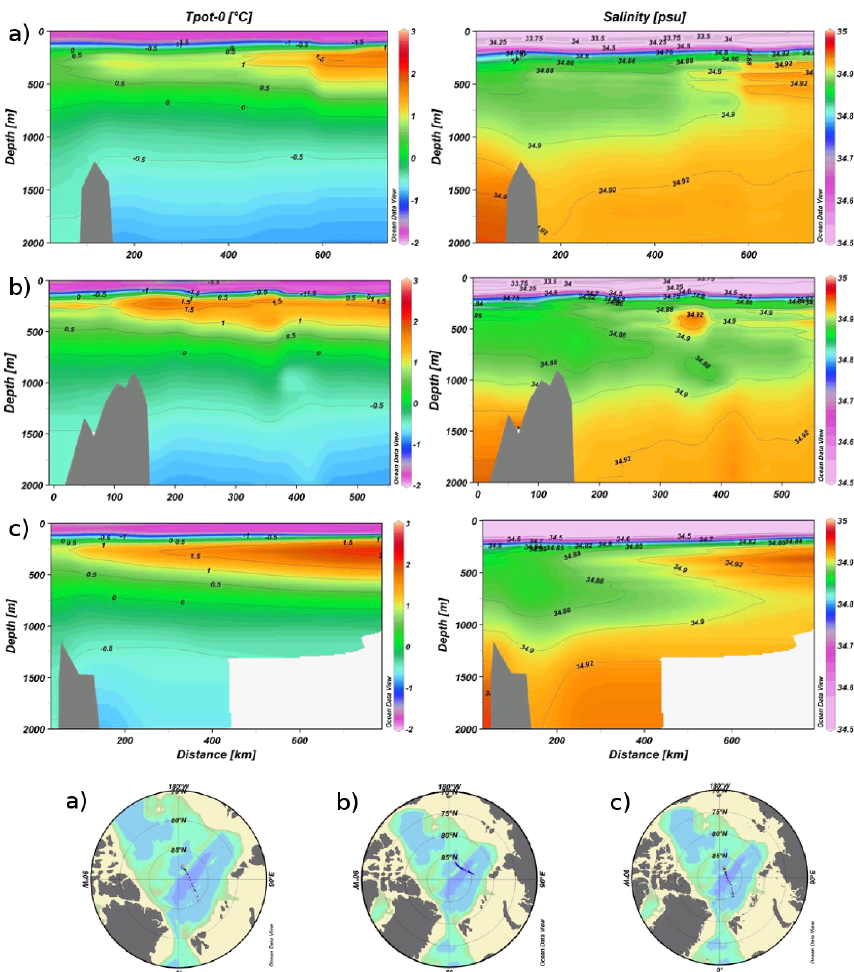
Fig. 16a. Sections of potential temperature and salinity from the Gakkel Ridge (right) across the Amundsen Basin and the Lomonosov Ridge into the Makarov Basin from different years: upper panel and left map – 1991 ( Oden ); centre panel and centre map – 1996 ( Polarstern ); lower panel and right map – 2001 ( Oden